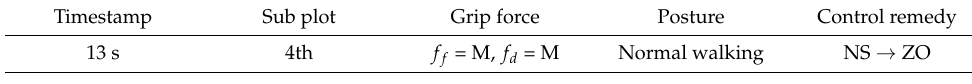
Table 10. Summary of experimental results (Downhill: v = ZO, S g = NS).